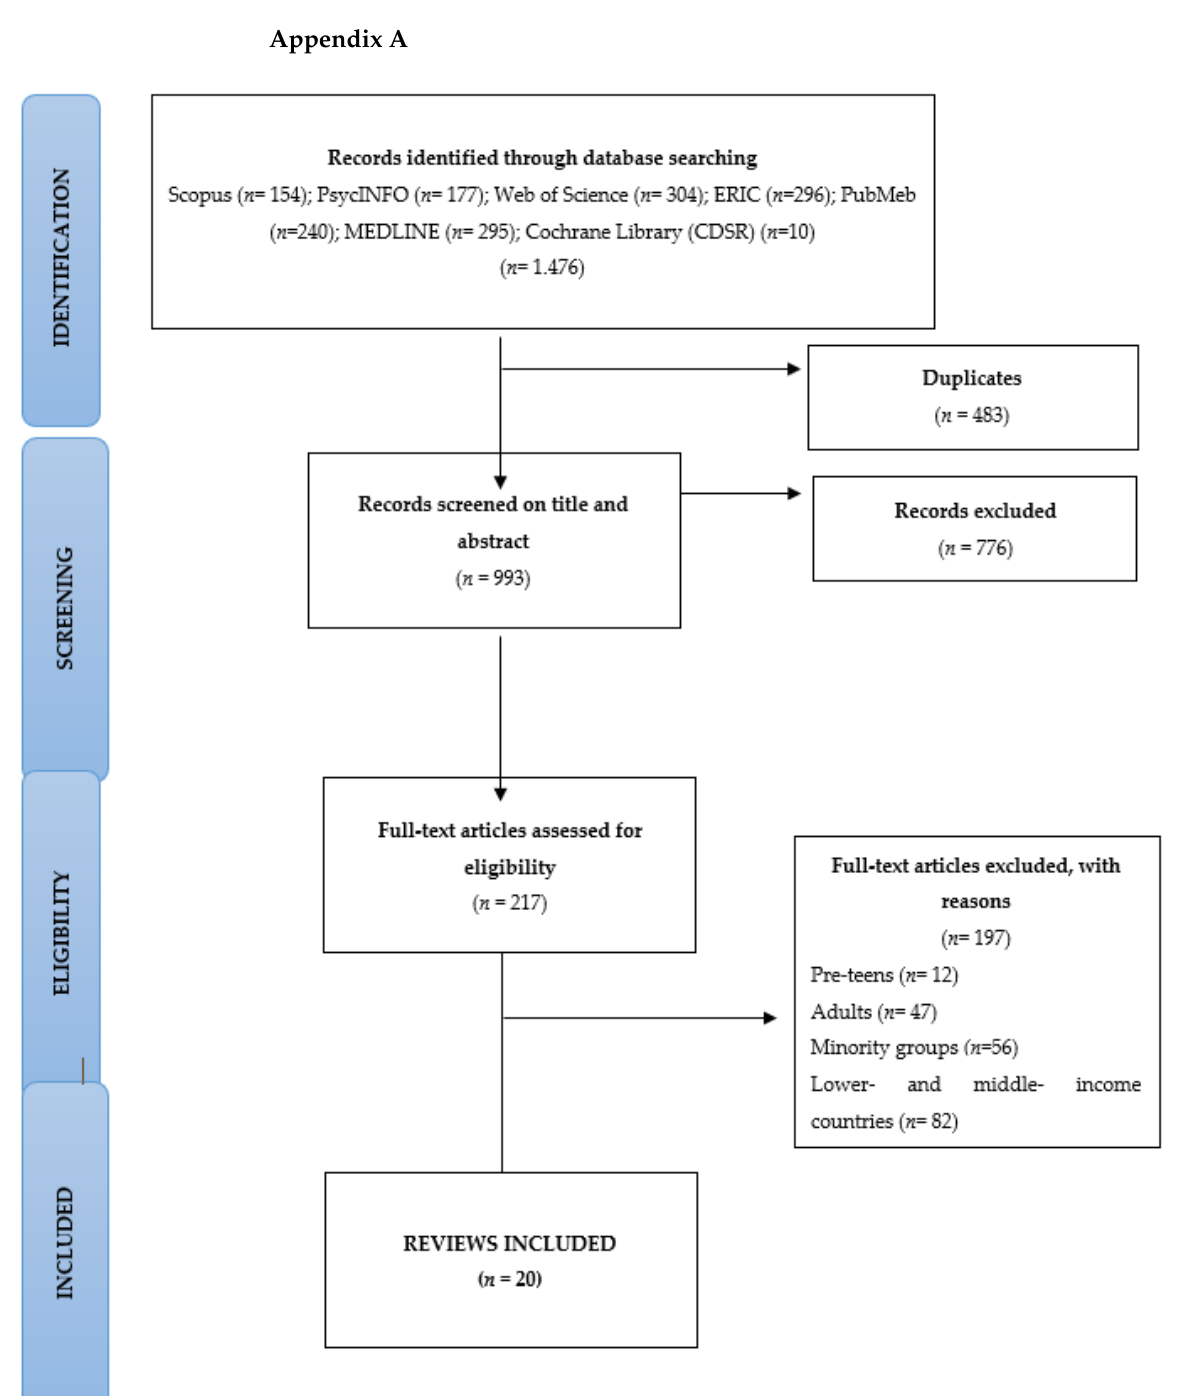
Figure A1. Flow diagram Preferred reporting items for systematic reviews and meta-analysis, PRISMA).